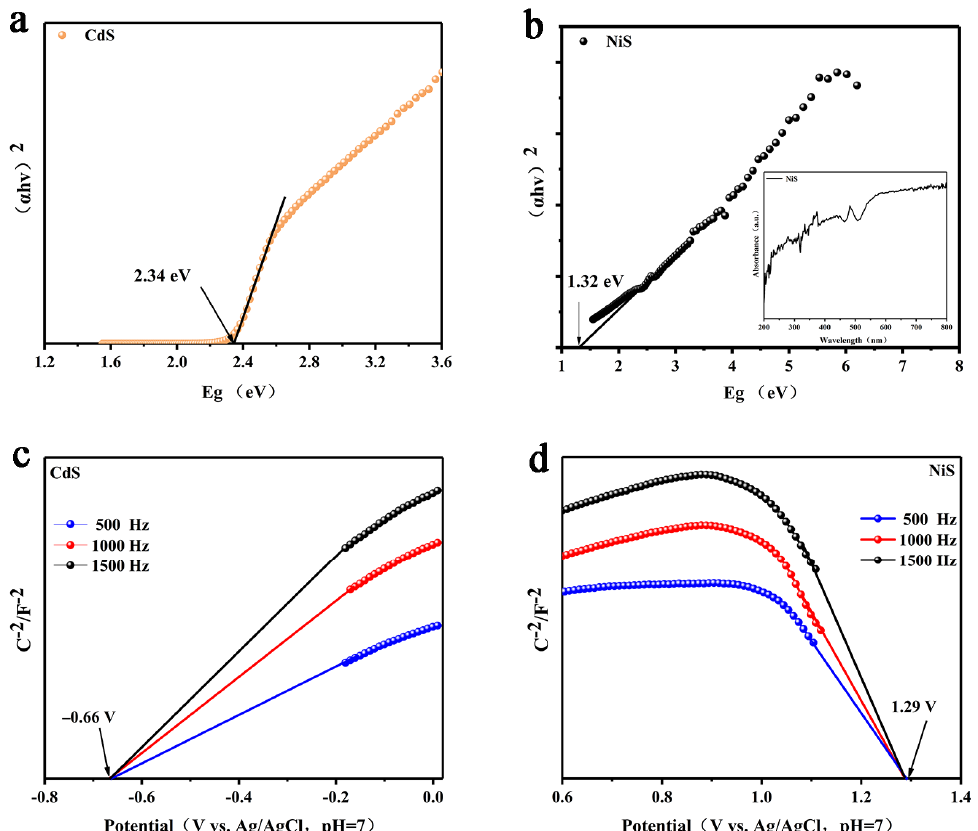
Figure 7. Tauc plots of ( a ) CdS; ( b ) NiS; Mott–Schottky plots of ( c ) CdS; ( d ) NiS (V vs. Ag/AgCl, pH = 7).